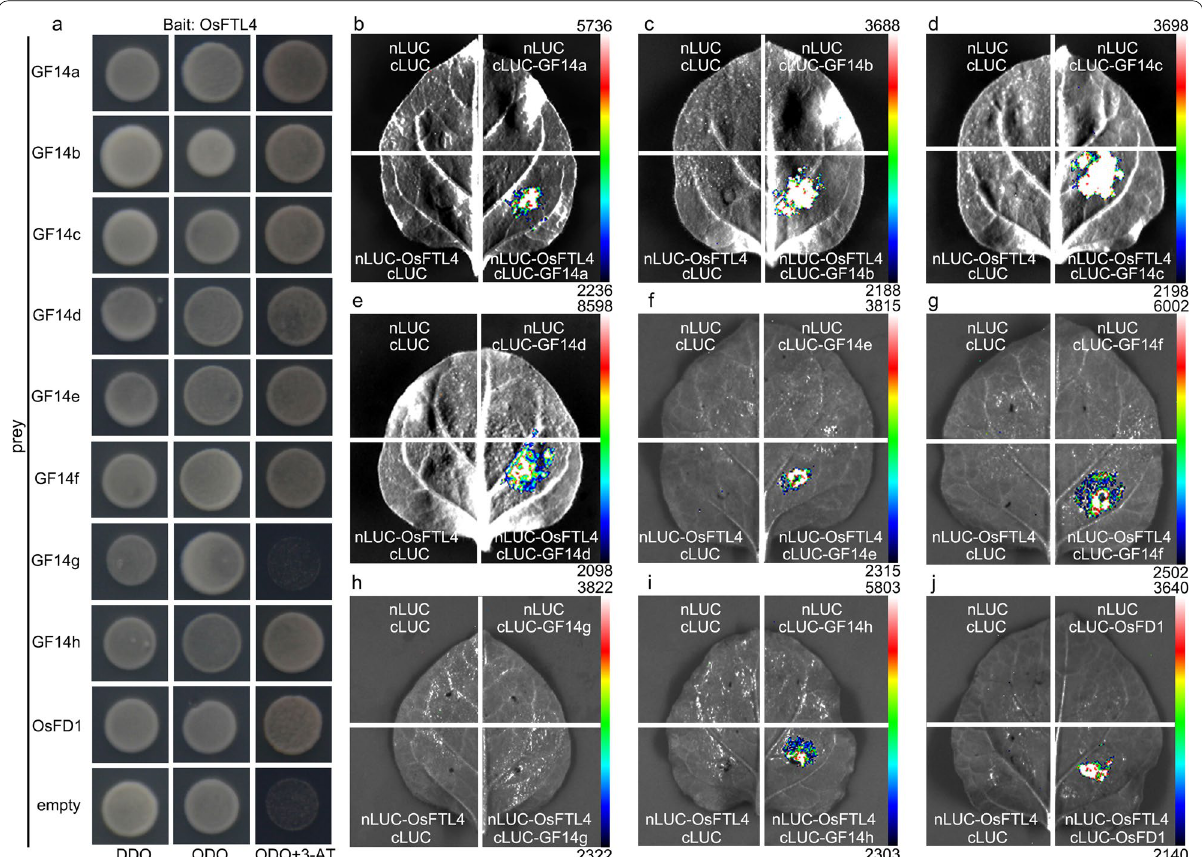
Fig. 5 Interactions among OsFTL4, 14-3-3, and OsFD1 proteins. a Y2H assay. OsFTL4 was used as bait (GAL4-BD, BD), whereas GF14a to GF14h and OsFD1 were used as prey (GAL4-AD, AD). DDO: SD/-L/-T, QDO: SD/-L/-T/-H/-A. The 3-AT concentration was 25 mM. The interaction between OsFTL4 and GF14a b , GF14b c , GF14c d , GF14d e , GF14e f , GF14f g , GF14g h , GF14h i , or OsFD1 j was determined by the LCI assay involving N. benthamiana leaf epidermal cells. Effect of OsFTL4 on the activation of OsMADS15 expression by FAC. Data are presented as the mean three independent